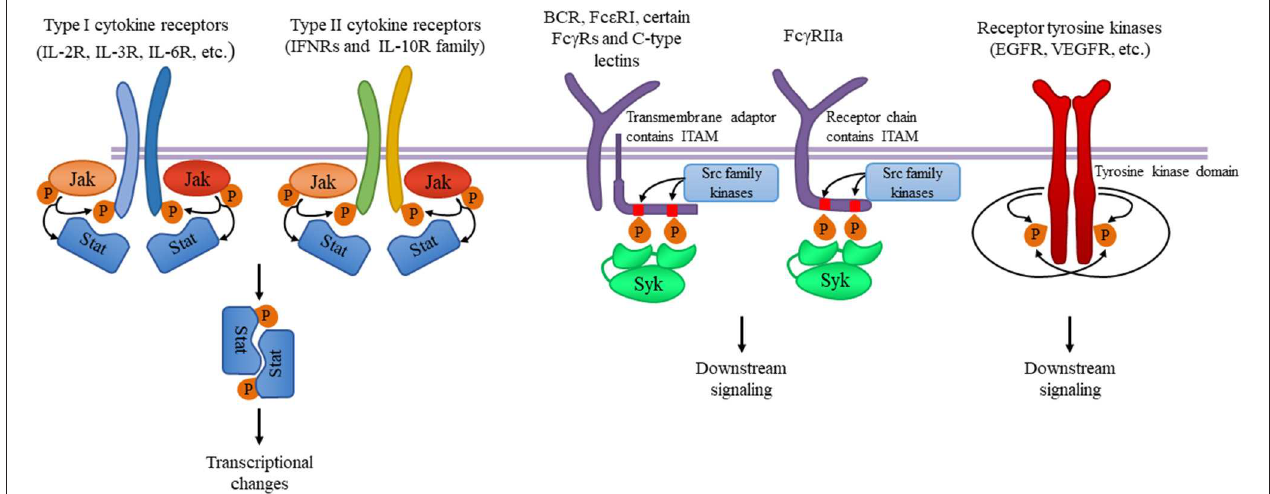
FIGURE 1 | Tyrosine kinases and their signaling pathways. Type I and type II cytokine receptors utilize Janus kinases for the initiation of downstream signaling. Type I cytokine receptor superfamily shares a common amino acid motif WSXWS. Within this family receptors containing the common γ chain ( γ c) recognize IL-2, IL-4, and IL-13 among others utilizing Jak1 and Jak3. Cytokines including IL-3 and IL-6 are also recognized by type I cytokine receptors acting through Jak1/Jak2 heterodimers or Jak2 homodimers, respectively. The type II cytokine receptor family includes receptors activated by interferons (IFNs) and the IL-10 family utilizing heterodimers of Jak1 along with Jak2 or Tyk2. Ligand binding leads to Jak activation resulting in phosphorylation of the receptor and downstream signal transducers and activators known as Stats mediating transcriptional changes (more information in the text). Src-family kinases and Syk are involved in several immune cell signaling pathways like immunoreceptor, integrin and C-type lectin signaling. Upon ligand binding, activation of Src-family kinases leads to the phosphorylation of tyrosine residues in immunoreceptor tyrosine-based activation motifs (ITAMs), that can be part of a transmembrane adaptor molecule like in case of B cell receptor (BCR), Fc ε RI, and certain Fc γ Rs and C-type lectins, or of the receptor chain itself like in Fc γ RIIa in humans. Syk is recruited to the dually phosphorylated ITAMs and becomes activated resulting in the recruitment and activation of various further adapter proteins promoting downstream signaling. Receptor tyrosine kinases, for example EGFR